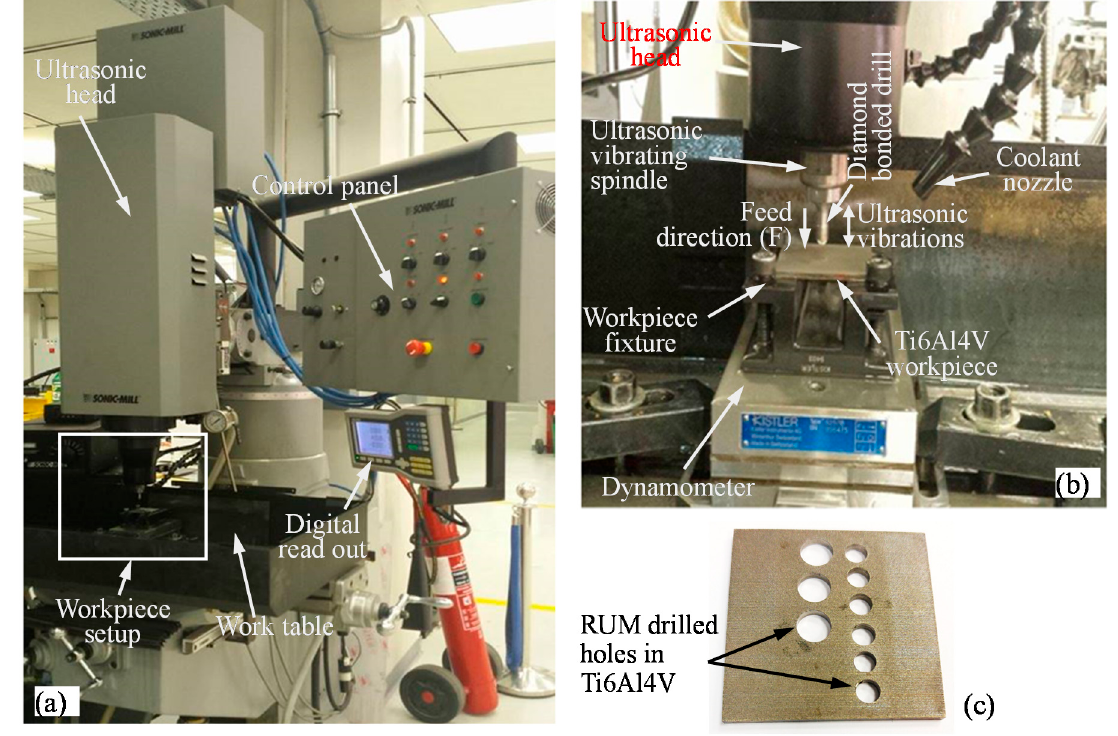
Table 1. Chemical composition of the Ti6Al4V.